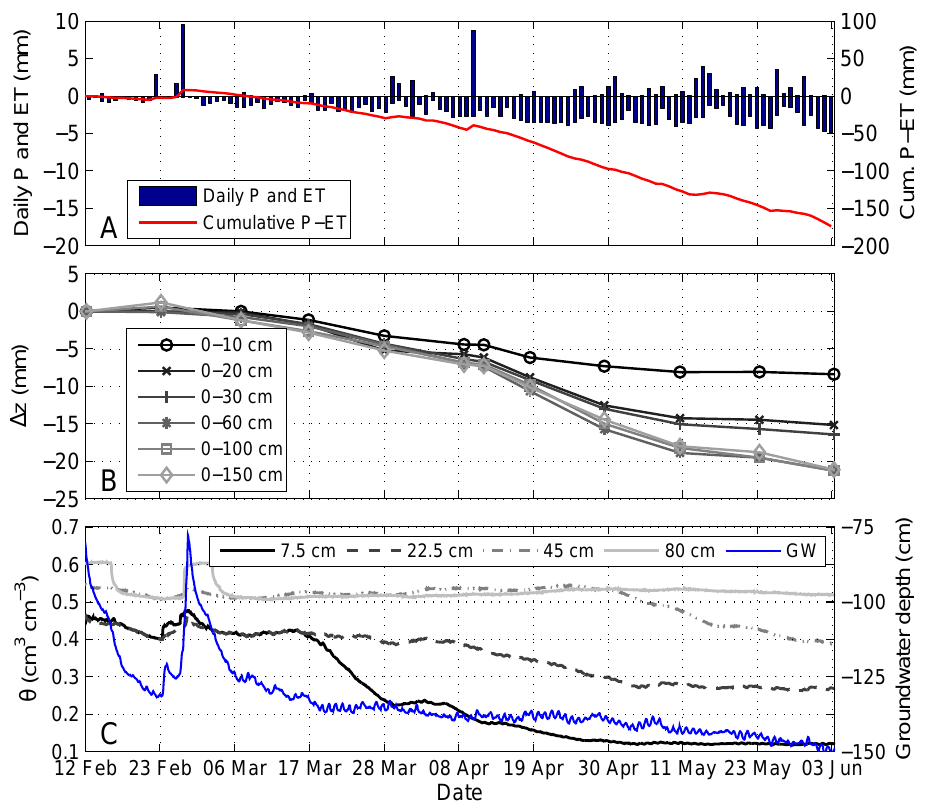
Fig. 4. Daily precipitation P , daily evapotranspiration ET and cumulative net precipitation P –ET (A) , cumulative layer thickness change 1z in six soil layers (B) , volumetric soil moisture content θ from CS616 sensors at four depths, and groundwater depth (C) at field A